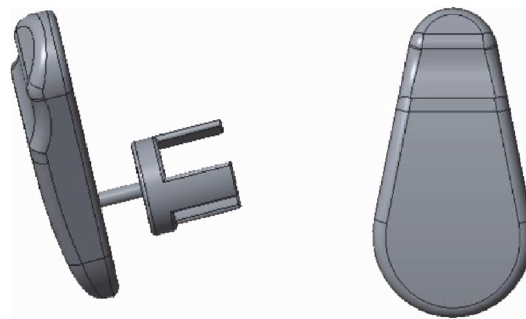
Figure 7: Modi fi ed ossicular prosthesis.